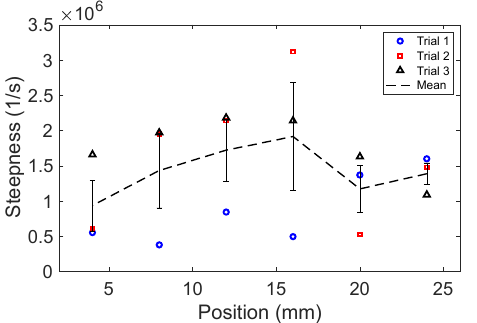
Figure 7. ( a ) Schematic representatives of V-shaped waveforms in Figure 6 for low pulse energy and high pulse energy, ( b ) Normalized peak-to-peak amplitude evolution with propagation distance for Ti-6Al-4V AM, with mean and standard deviation.